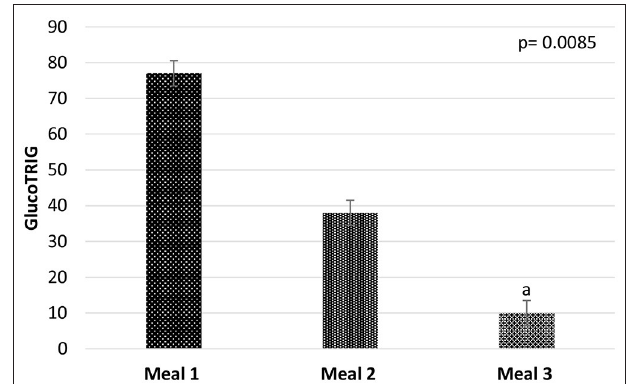
FIGURE 2 | Mean GlucoTRIG values of the meals M1 ( n = 10), M2 ( n = 10), and M3 ( n = 10). Data presented as mean ± SEM. P -value represents the repeated measures of ANOVA between the meal groups in a model. a GlucoTRIG value of Meal 3 is significantly differnet from meal 1 ( p =